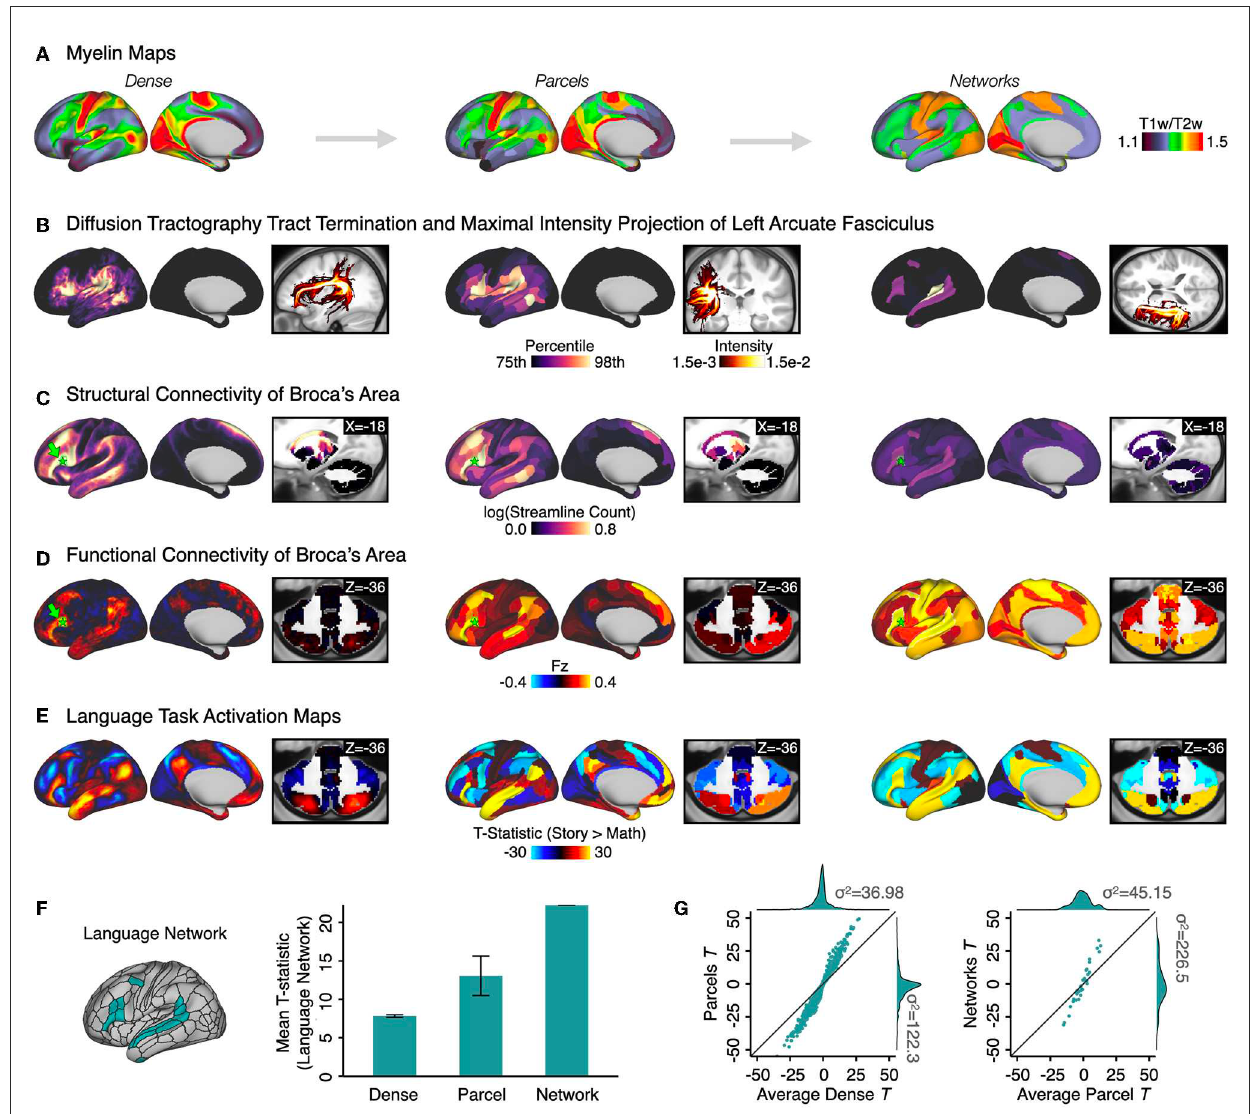
FIGURE4 Extracting multi-modal processing features at multiple levels of resolution. Output features from multiple modalities are shown, as an example of a cross-modal analysis that may be done for a study. Here, features were computed from a cohort of N = 339 unrelated subjects from the HCP Young Adult cohort (Van Essen et al., 2013). In addition to cross-modality support, QuNex offers feature extraction at “dense” (i.e., full-resolution), parcel-level and network-level resolutions. All features are shown below at all three resolutions. We used the Cole-Anticevic Brainwide Network Parcellation (CAB-NP) (Glasser et al., 2016a; Ji et al., 2019b), computed using resting-state functional connectivity from the same cohort and validated and characterized extensively in Ji et al. (2019b). (A) Myelin maps, estimated using the ratio of T1w/T2w images (Glasser and Van Essen, 2011). (B) Left arcuate fasciculus computed via diffusion tractography (Warrington et al., 2020). Surface views show the cortical tract termination (white-gray matter boundary endpoints) and volume views show the maximal intensity projection. (C) Structural connectivity of Broca’s area